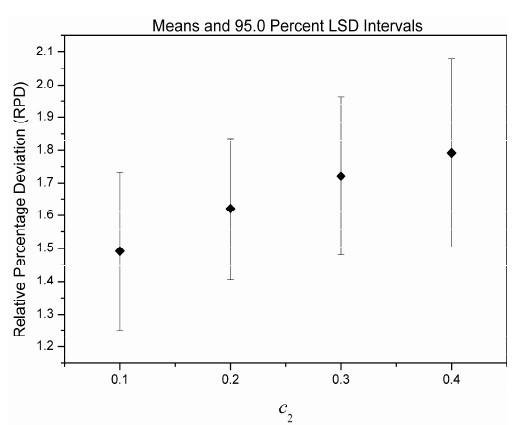
Fig. 10. Means plot and LSD intervals for parameter c 2